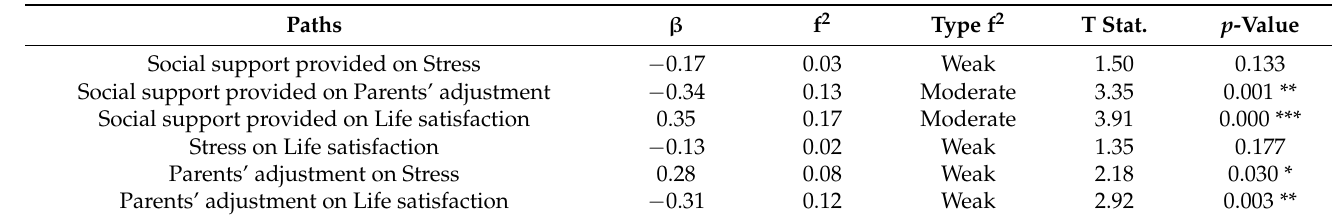
Table 4. Path coefficient, effect size, magnitude, and significance of the structural social support provided